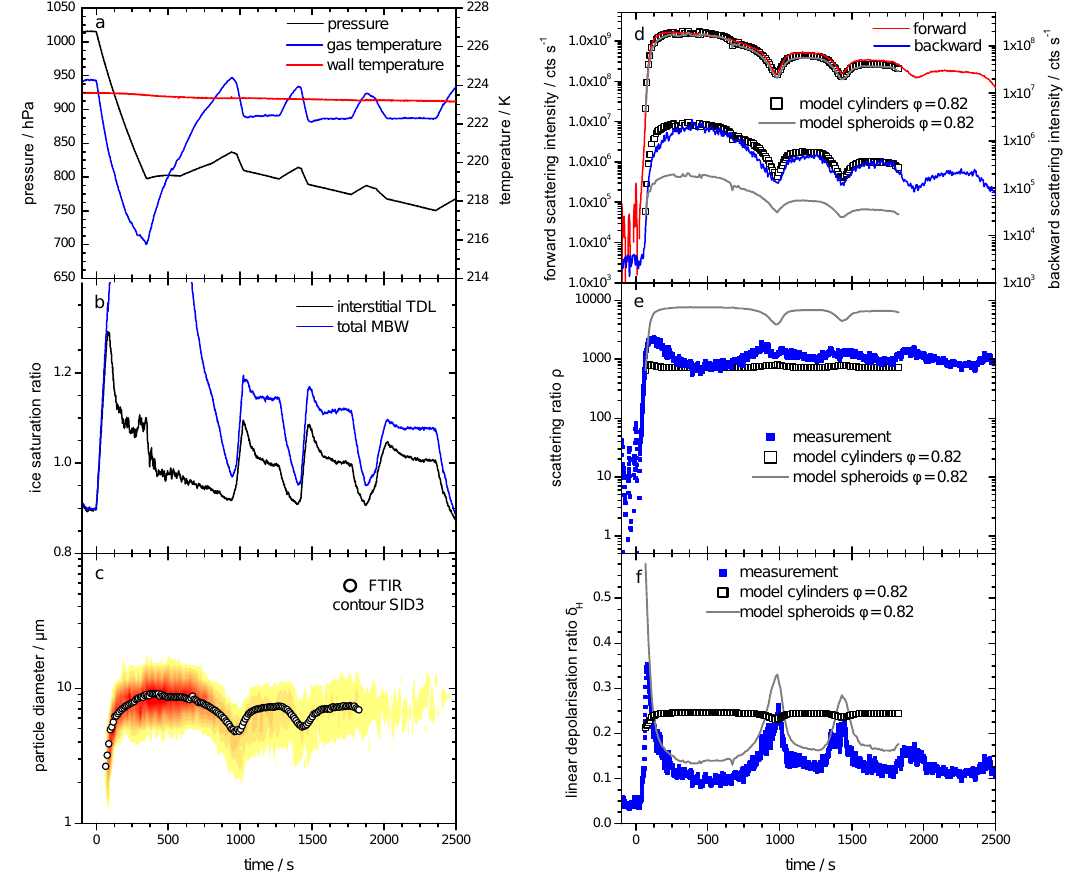
Fig. 11. As Figs. 9 and 10 but for the heterogeneous ice nucleation experiment HALO06 25 conducted at a higher temperature of T initial = 224 . 3K. Note the larger sizes of the ice particles grown in this experiment compared to the experiments ICE01 14 and HALO06 30. Starting at about t = 500s experiment time, the ice cloud particles were repeatedly forced to sublimate and grow.